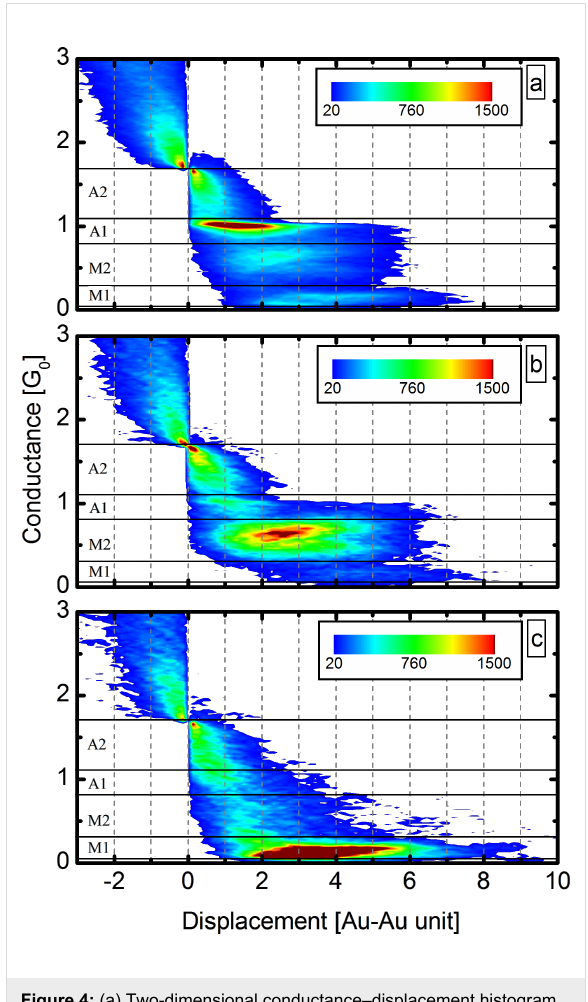
Figure 4: (a) Two-dimensional conductance–displacement histogram for all of the measured traces, showing the appearance of the same configurations as the grey curve in Figure 1. (b,c) The 2D conduc- tance–displacement histograms for the same traces that were used to plot the light/dark green, double selected conditional histograms in Figure 3. Panels (b) and (c) correspond to molecular traces selected for the M2 and M1 region, respectively. The electrode-displacement is given in Au–Au distance unit, i.e., the distance of neighbor Au atoms in clean atomic chains. The 2DCDHs are normalized to the number of included